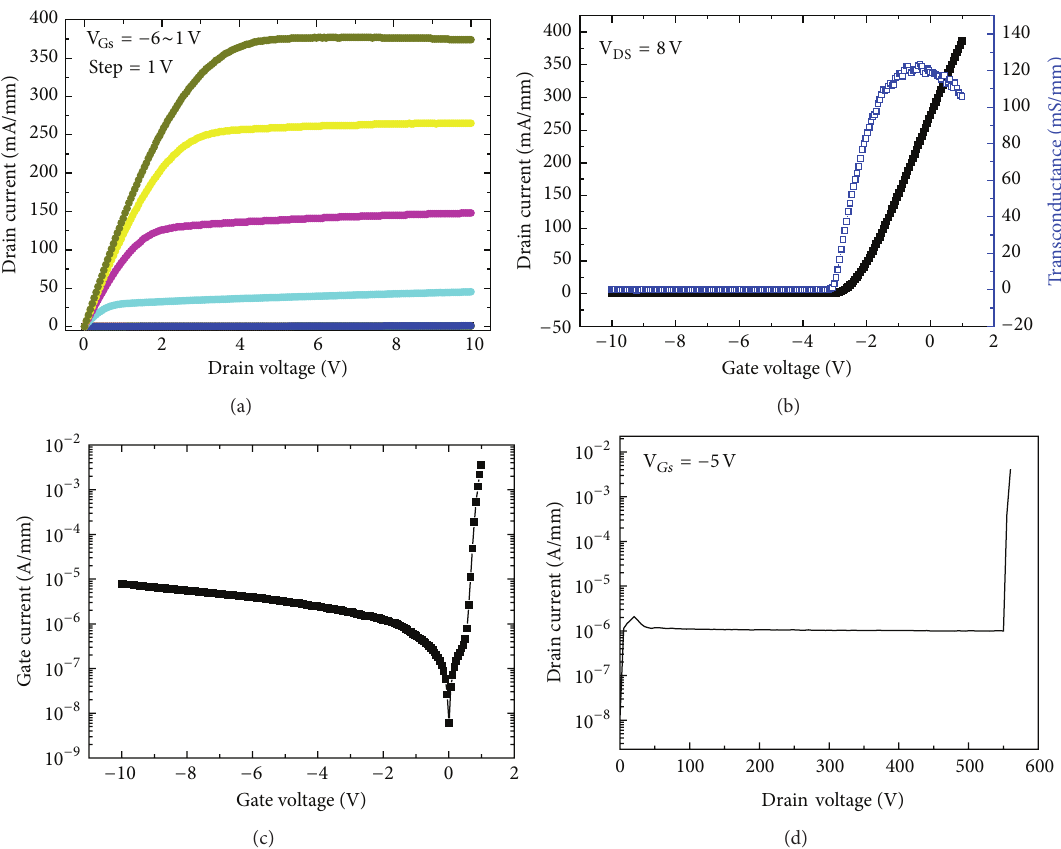
Figure 5: I - V characteristics of the fabricated device with AlSiC precoverage layer. (a) Drain current, (b) transfer characteristics, (c) gate leakage current, and (d) breakdown